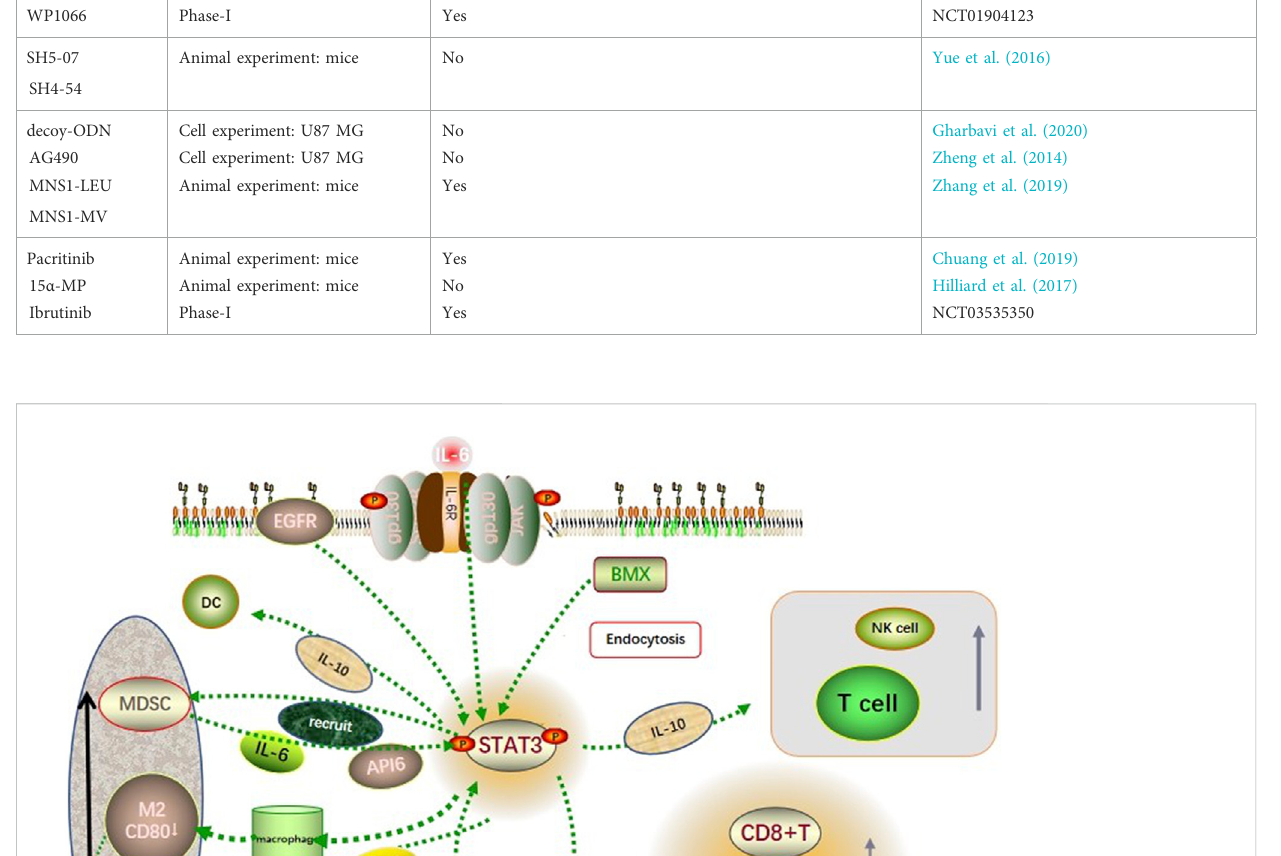
TABLE 1 Studies on the inhibitory effect of various STAT3 inhibitors on STAT3 pathway. Drug Experimental design